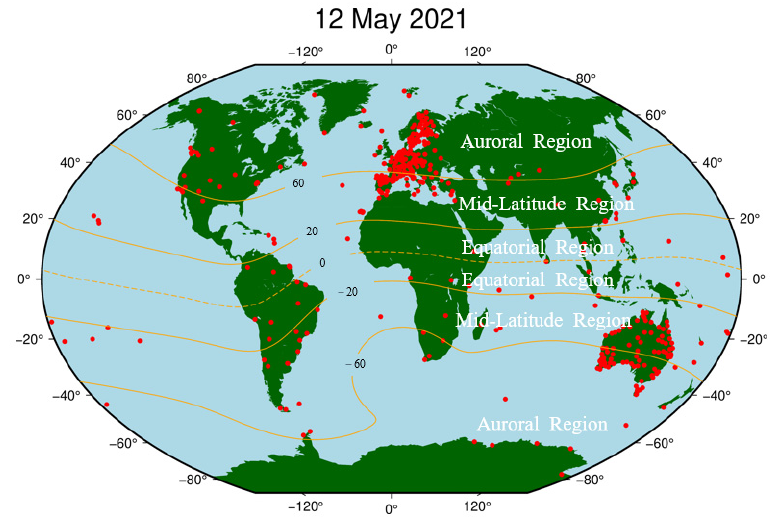
Figure 2. Location distribution of BDS sites on the geomagnetic storm